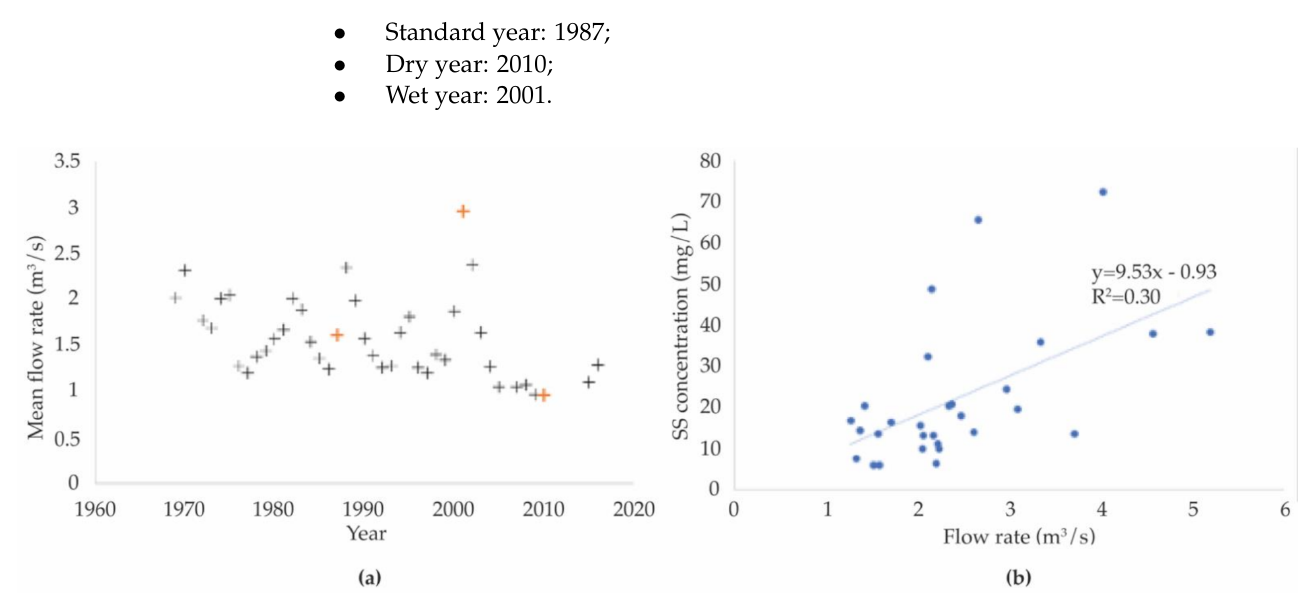
Figure 9. ( a ) Yearly mean flow rates from 1969 to 2016 [13]; red crosses show the typical years used for modelling. ( b ) Suspended solid concentrations as a function of the flow rate (values from [14,38,39]); linear regression used for modelling.